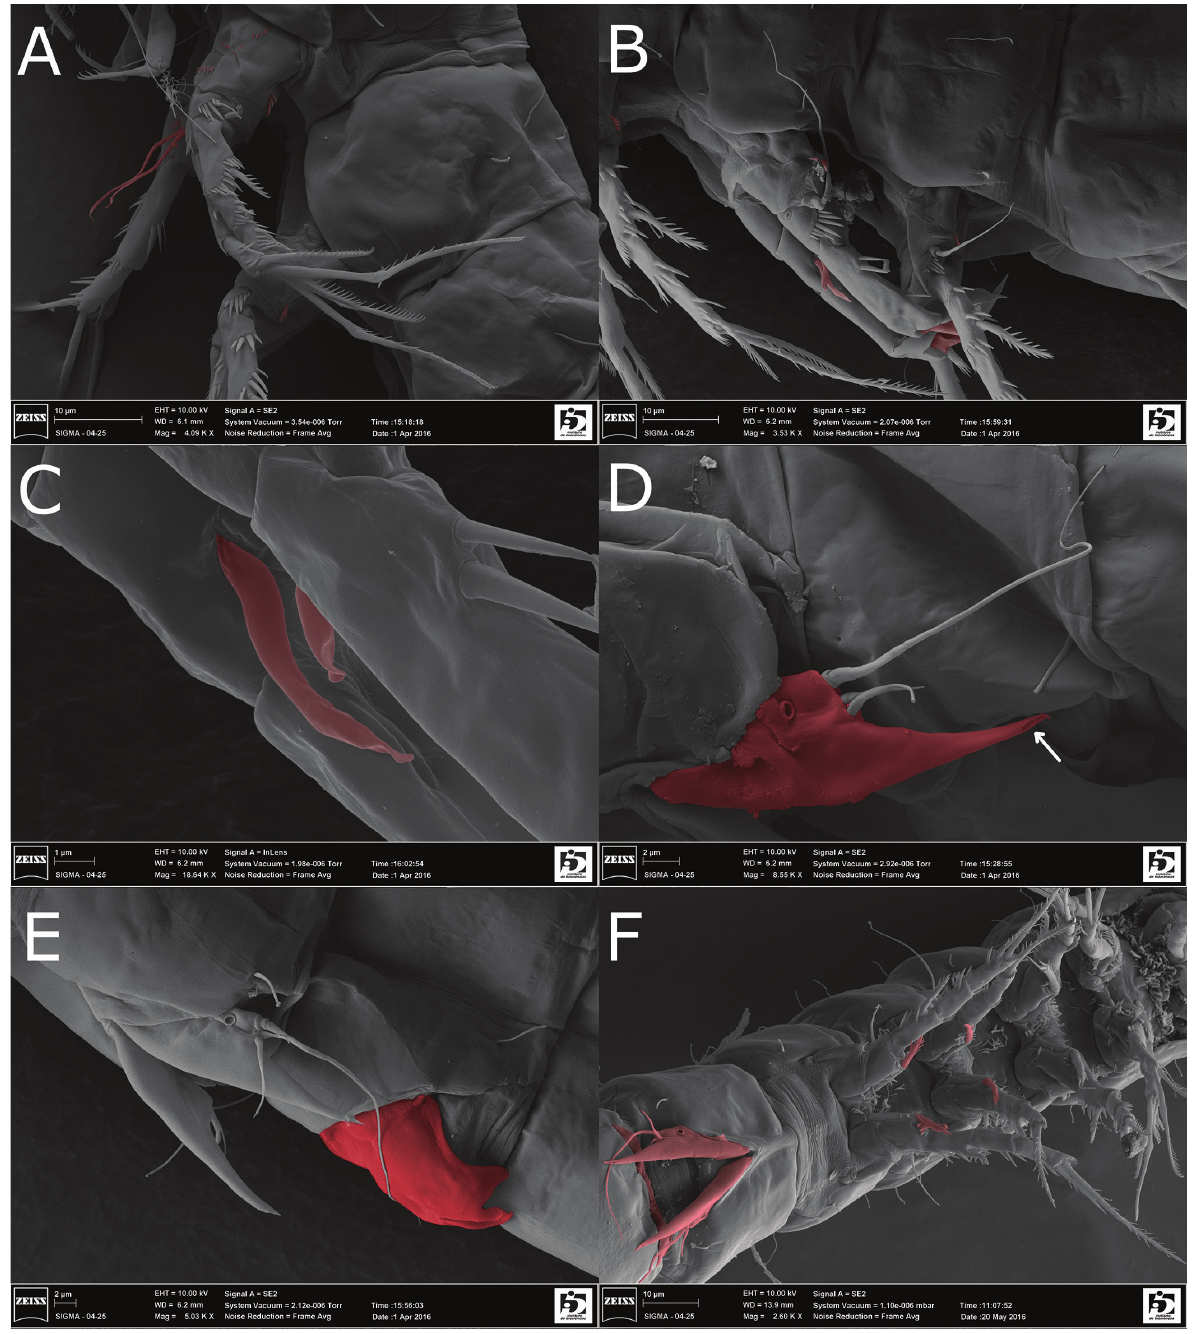
Figure 7. SEM image of Eirinicaris antonioi sp. n. Male: A P1 showing inner seta of basis; B P3 with endopod and thumb in colour, P4; C claviform aesthetasc representing the endopod of P3; D P5, lateral view, with distal pore arrowed; E P5 and P6. Female: F pro- and urosomites, ventral view showing endopods of P3 and P4, and P5 and P6. Scale bars A = 10µm; B = 10µm; C = 1µm; D = 2µm; E = 2µm; F =